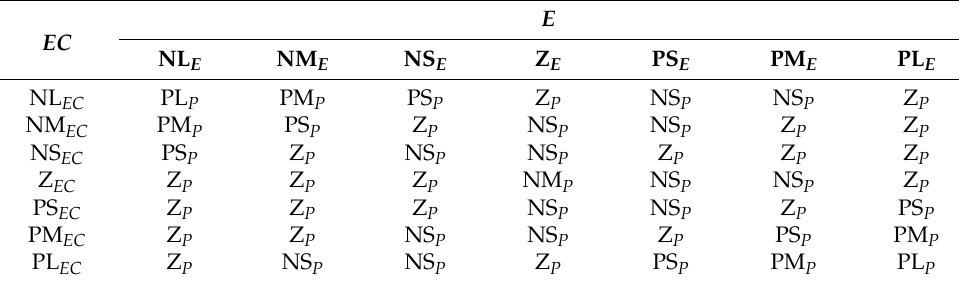
Table 1. ∆ P ratio coefficient of variation of fuzzy control rules.